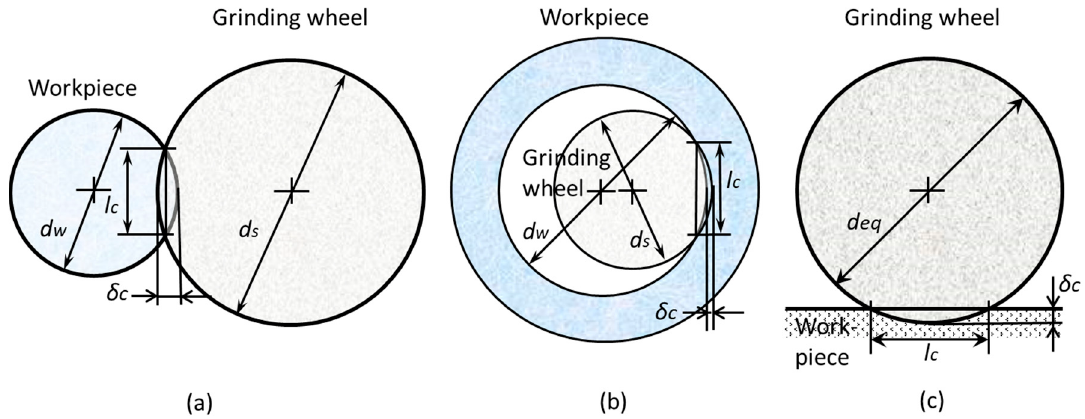
Figure 9. Contact length and deflection. ( a ) External grinding; ( b ) Internal grinding; ( c ) Equivalent wheel diameter.